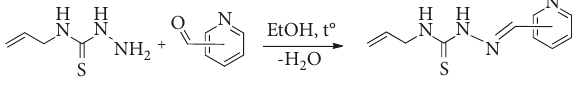
Scheme 2: Synthesis of 2-,3-, and 4-formylpyridine N 4 -